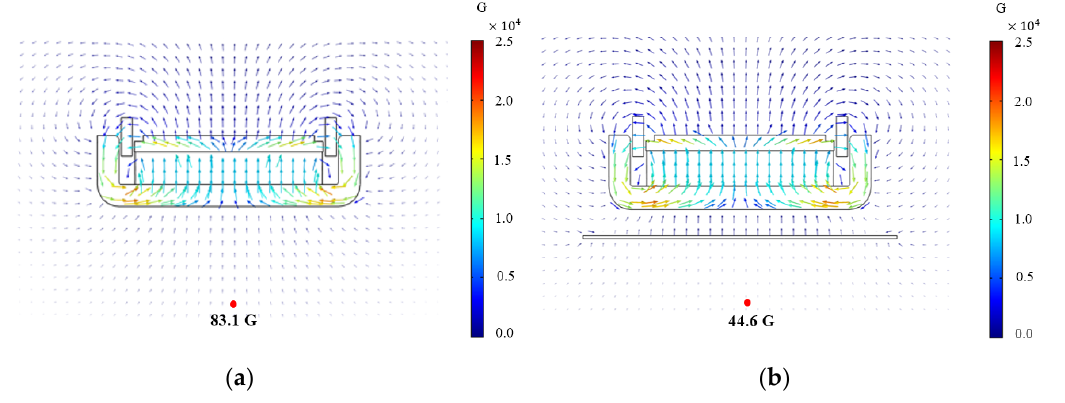
Figure 14. Magnetic flux line: ( a ) second design; ( b ) final design. Table 6. Comparison of analysis results between the prototype and second design.